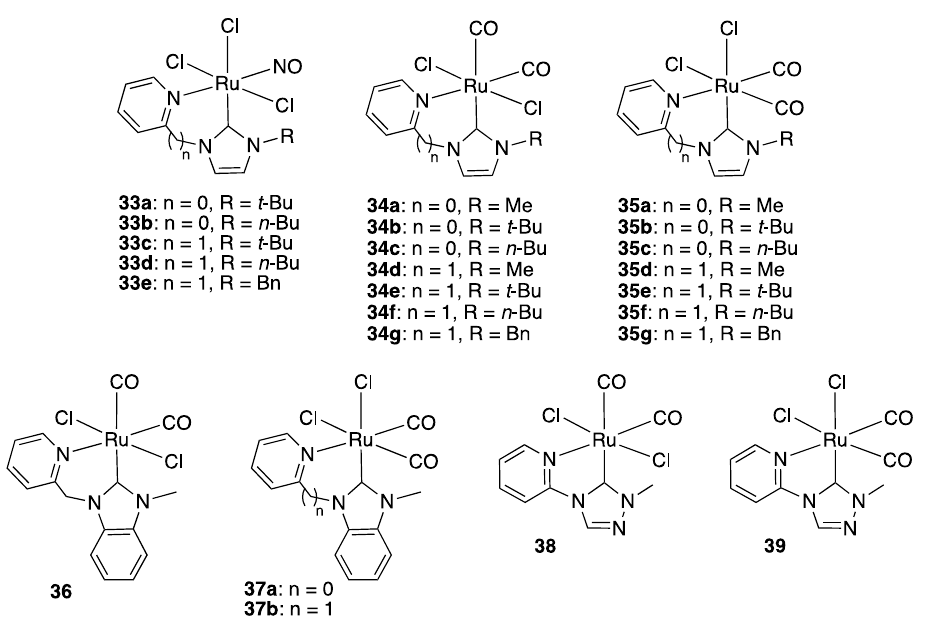
Figure 5. Pyridyl- or picolyl-functionalized imidazol-, benzimidazol- or triazol-2-ylidene octahedral Ru(II) complexes 33 – 39 .